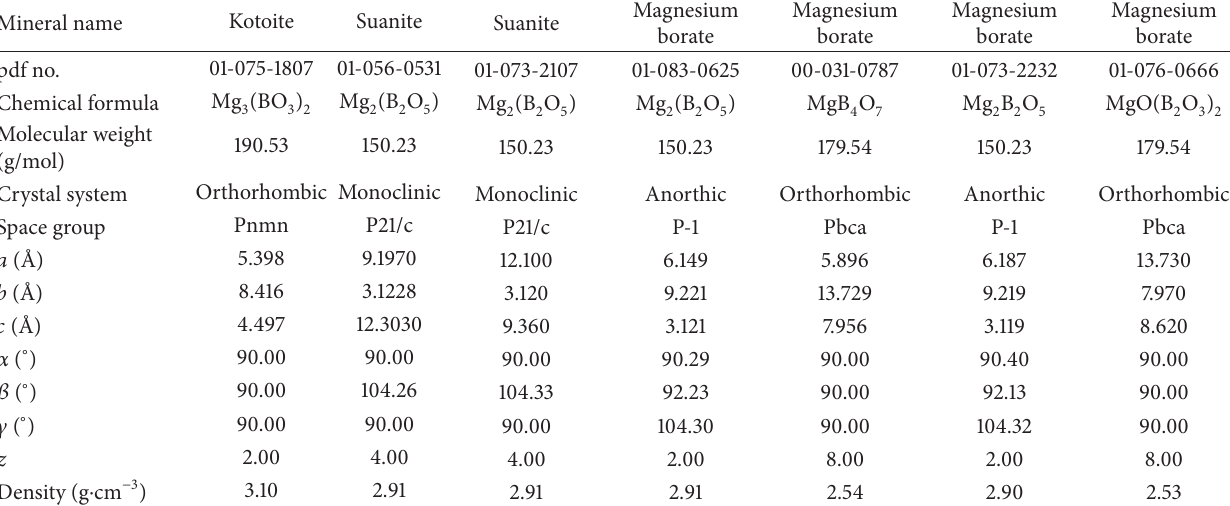
Table 2: Crystallographic data of synthesized dehydrated magnesium